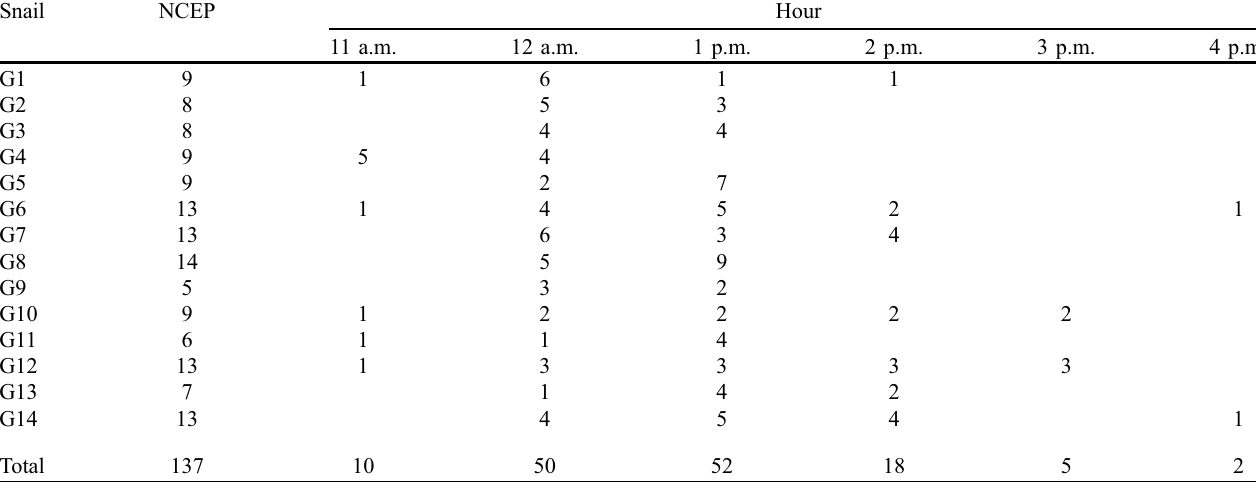
Table 1. Variation of the position of the cercarial emission peak for each individual